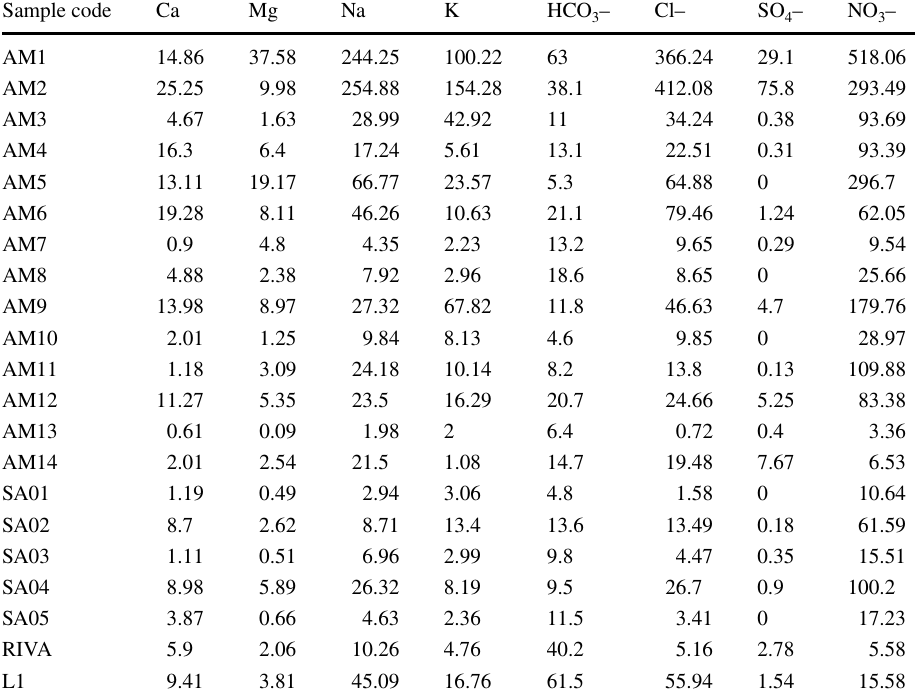
Concentration is